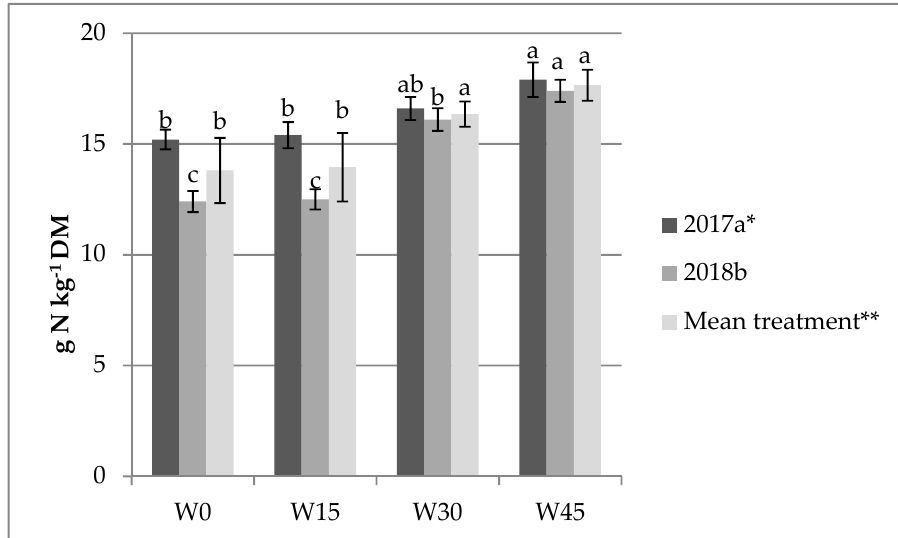
Figure 2. Nitrogen content in maize grain. W0—the control with no stillage treatment, W15—15 m 3 of stillage per hectare, W30—30 m 3 of stillage per hectare, W45—45 m 3 of stillage per hectare. * means of years regardless of treatments; ** means of treatments regardless of years. The same letter means not significantly di ff